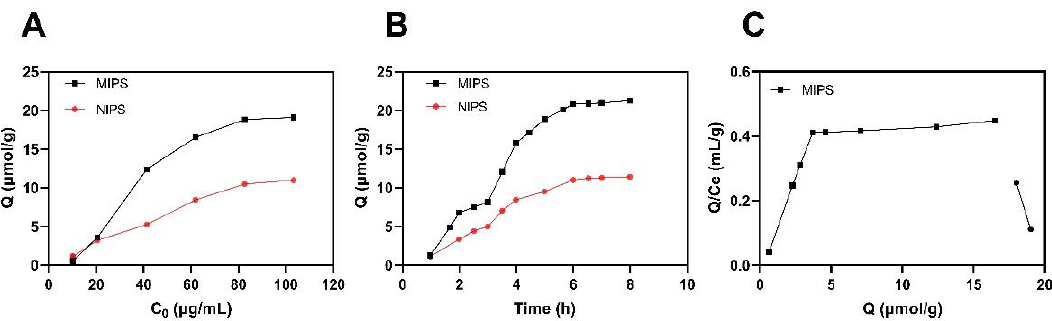
Figure 5. Isothermal adsorption ( A ) and Kinetic adsorption curves ( B ) of MIPS and NIPS and the Scatchard equation of MIPS ( C )